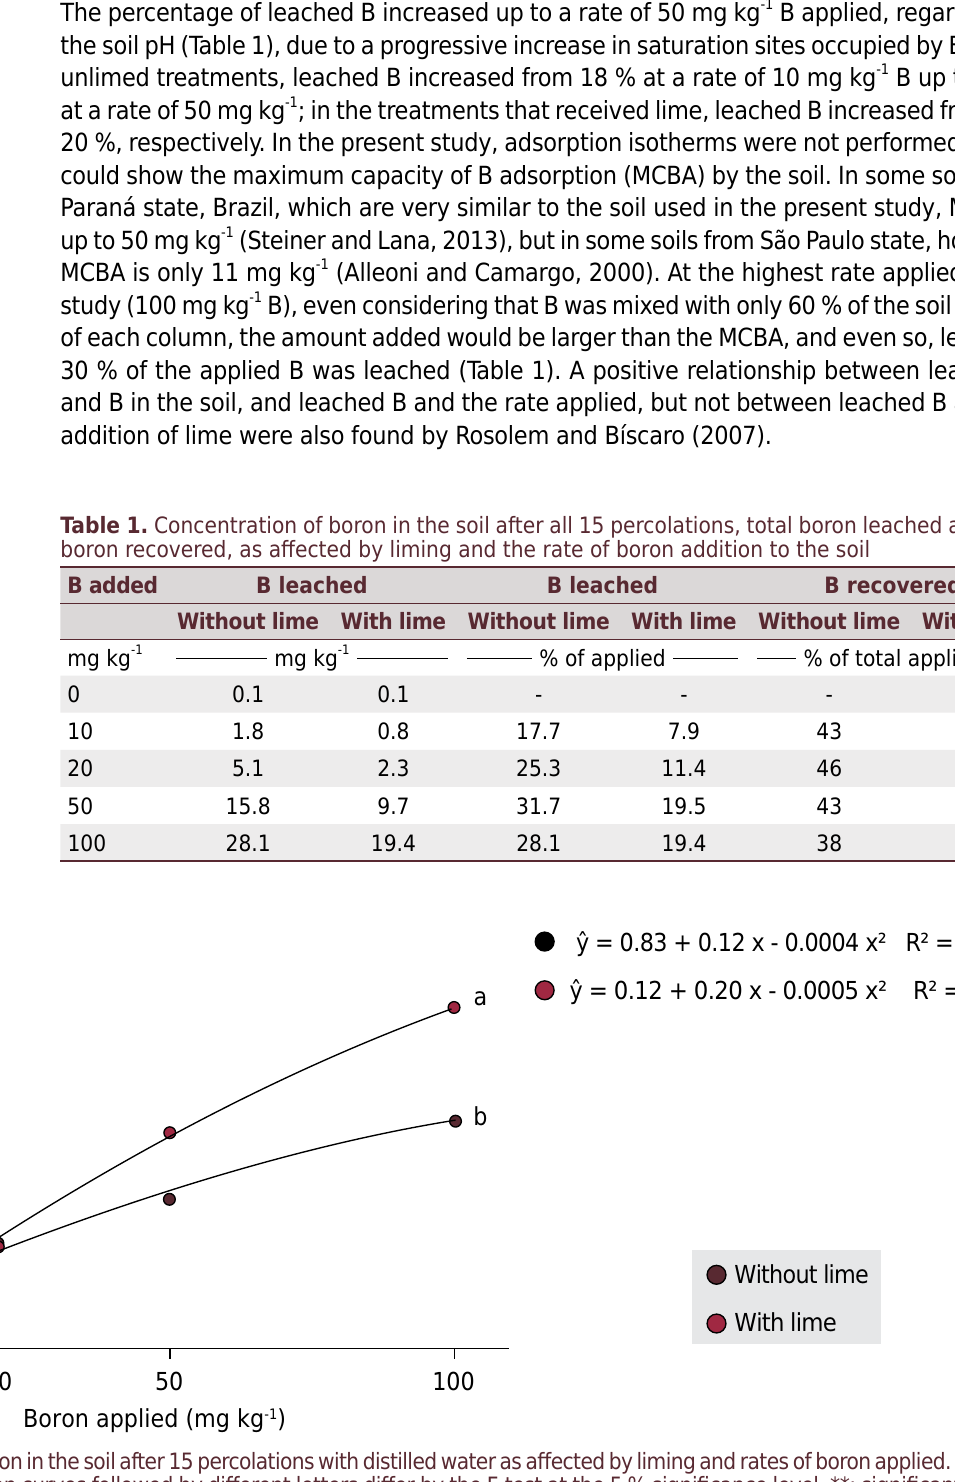
Figure 3. Concentration of boron in the soil after 15 percolations with distilled water as affected by liming and rates of boron applied. Average of three replications. Regression curves followed by different letters differ by the F-test at the 5 % significance level. **: significant at 1